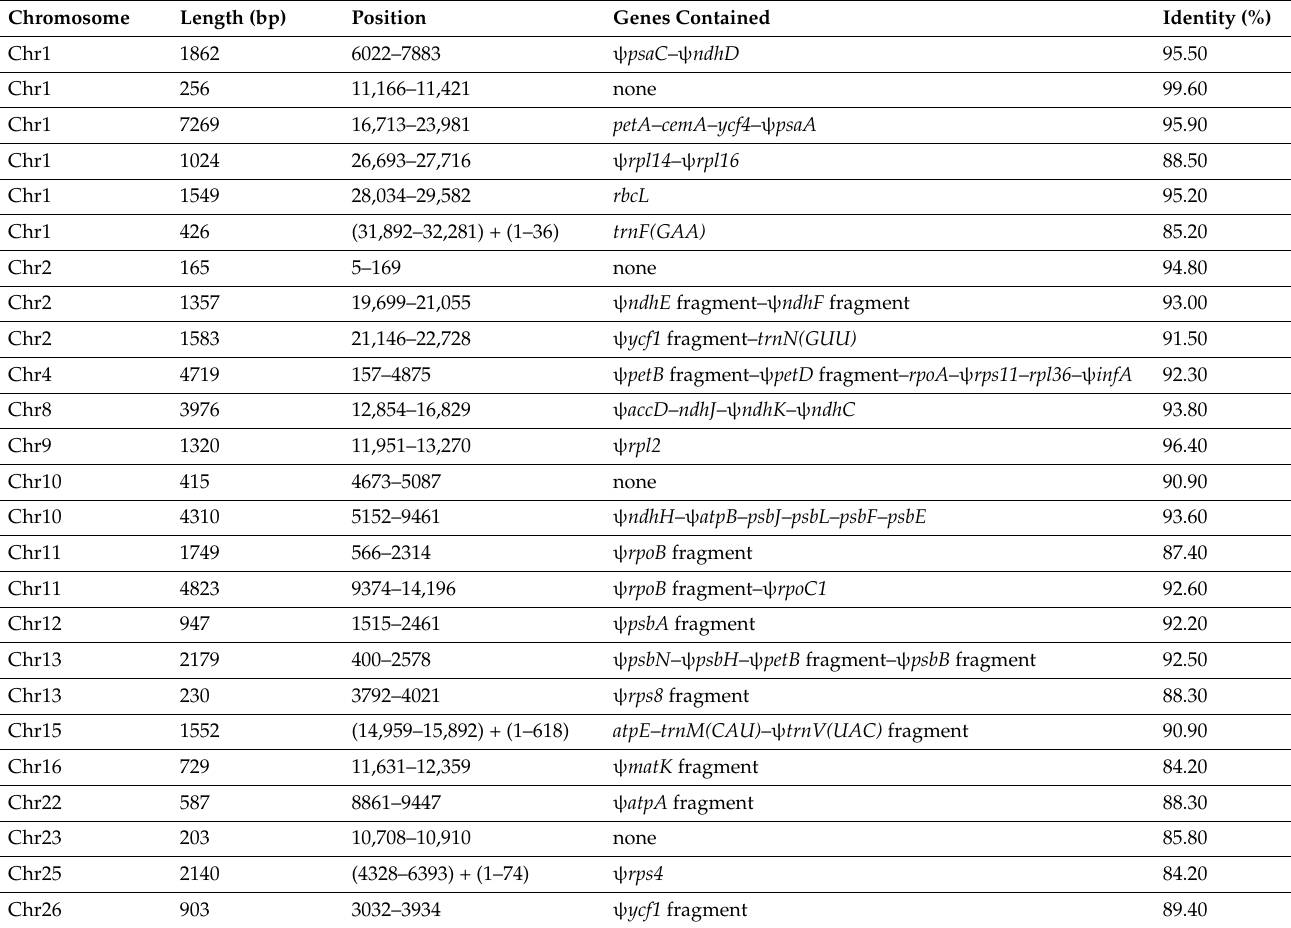
Table 3. Plastid-derived regions in the mitochondrial genome of Paphiopedilum